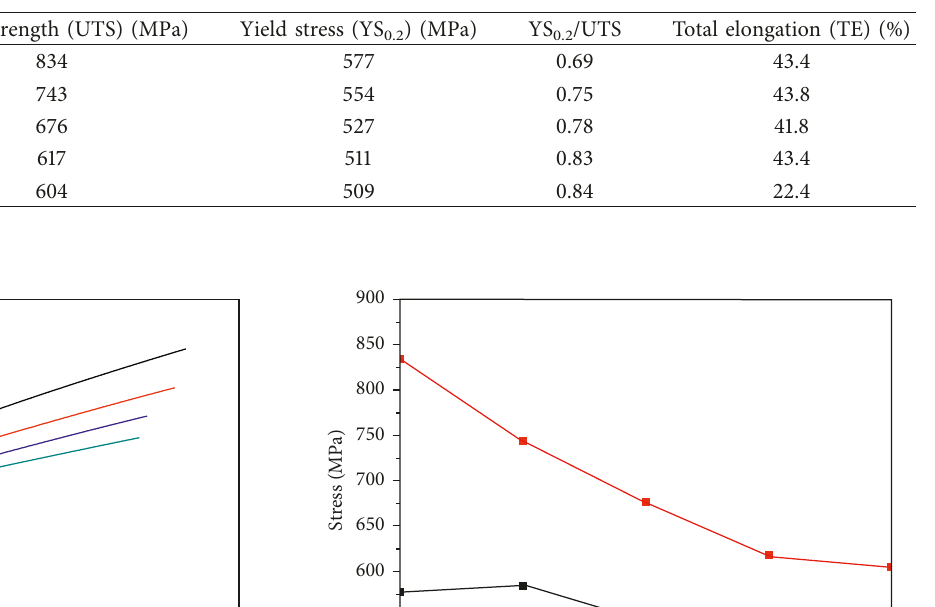
Table 2: Mechanical properties of the tensile tested steel at each temperature.